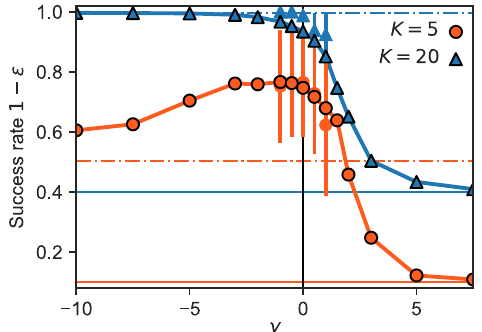
FIG. 6. Root finding on artificial trees. We show the success rate of the root-finding algorithms, with sets R of sizes K ¼ 5 and K ¼ 20 on artificial networks of T ¼ 50 edges. The results of OD are shown with solid lines and symbols, while the sampling results are shown with symbols and error bars of 1 standard deviation. The horizontal solid lines show the accuracy of randomly constructed sets R (no information retrieval), while the horizontal dotted lines show the expected success rate in the limit γ → −∞ , where a simple peeling technique is optimal. The sampled root sets are computed for γ ∈ f − 1 ; − 1 n ¼ 10 5